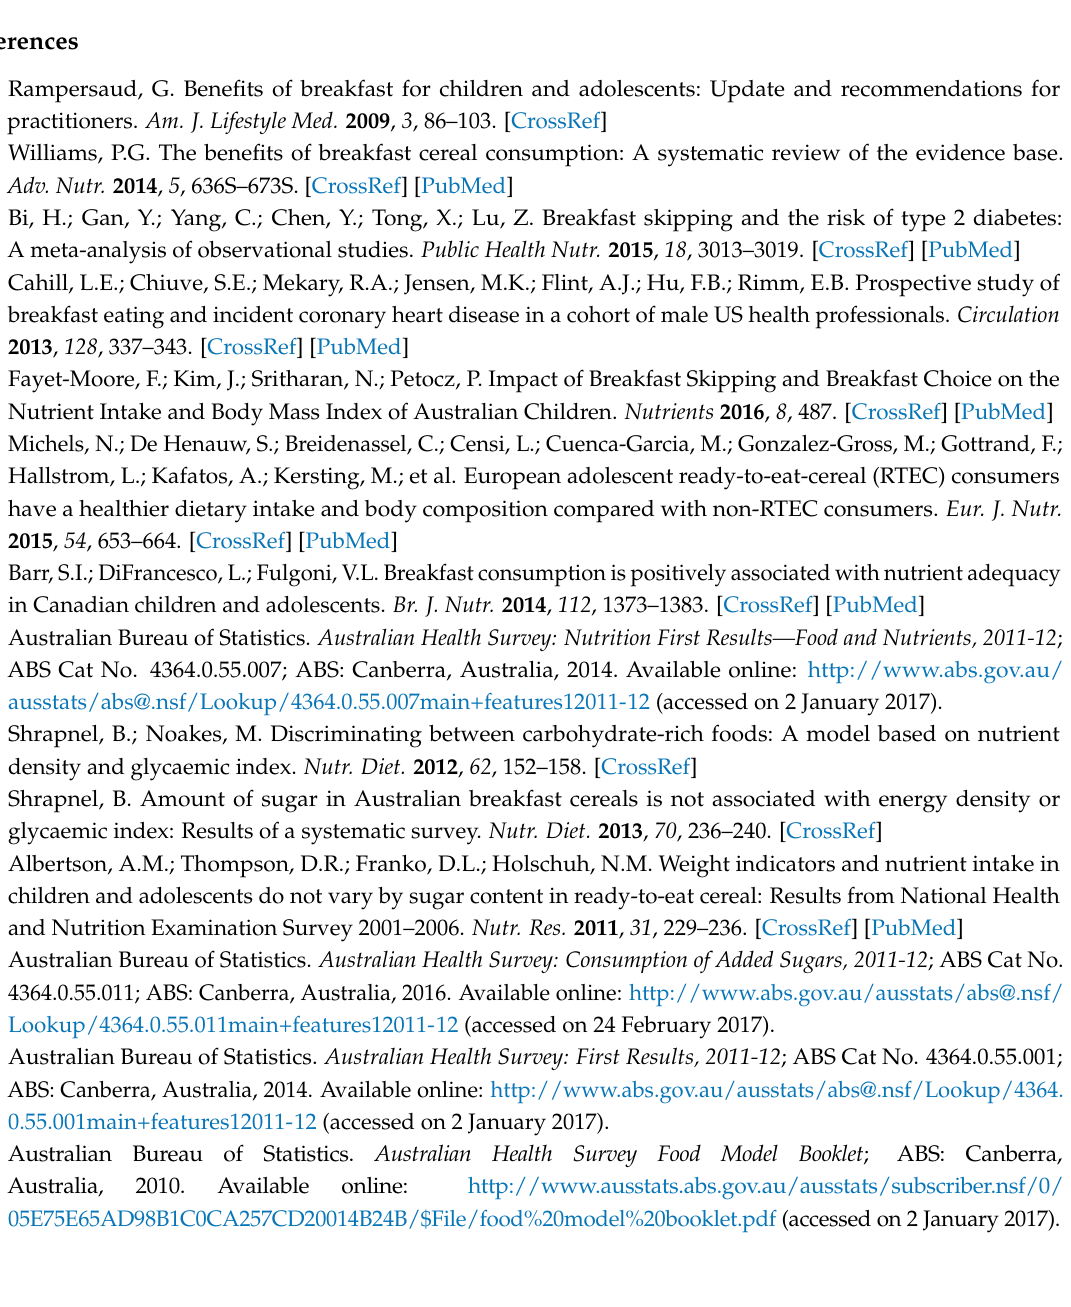
Table S1: The weighted percentage of breakfast cereal consumers among children and adolescents, 2–18 years, by type of breakfast cereal * consumed, Table S2: The contribution of the breakfast cereal to total daily nutrient intakes by type of breakfast cereal in breakfast cereal consumers *, Table S3: Total daily energy and nutrient intake by cereal type in breakfast cereal consumers